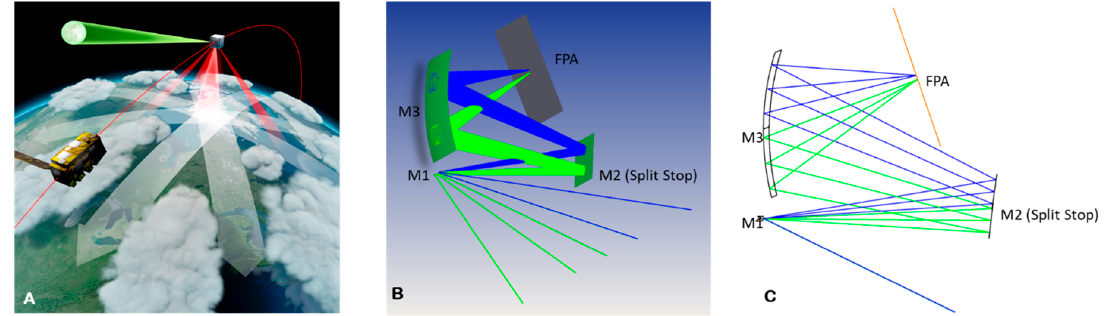
Figure 5. ( A ) Trutinor observatory, flying in constellation with an imager, performing lunar calibration and collecting multi-angular measurements; ( B ) and ( C ) 3D and 2D ray-trace representations of Trutinor optical design,